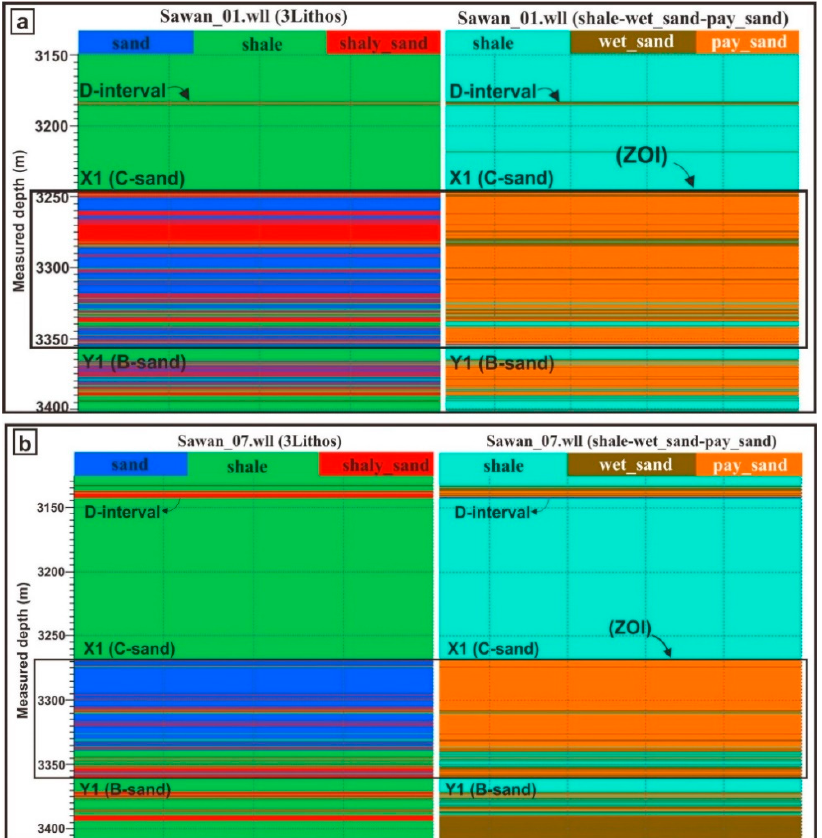
Figure 15. Facies log created for LGF using GR log to differentiate the sand (blue), shale (green), and the shaly_sand (red) facies (left side). Whereas, facies log generated using GR and resistivity (LLD) log to differentiate the pay-sands (orange), wet-sands (brown), and shale (cyan) facies (right side) for ( a ) S-01, and ( b ) S-07.